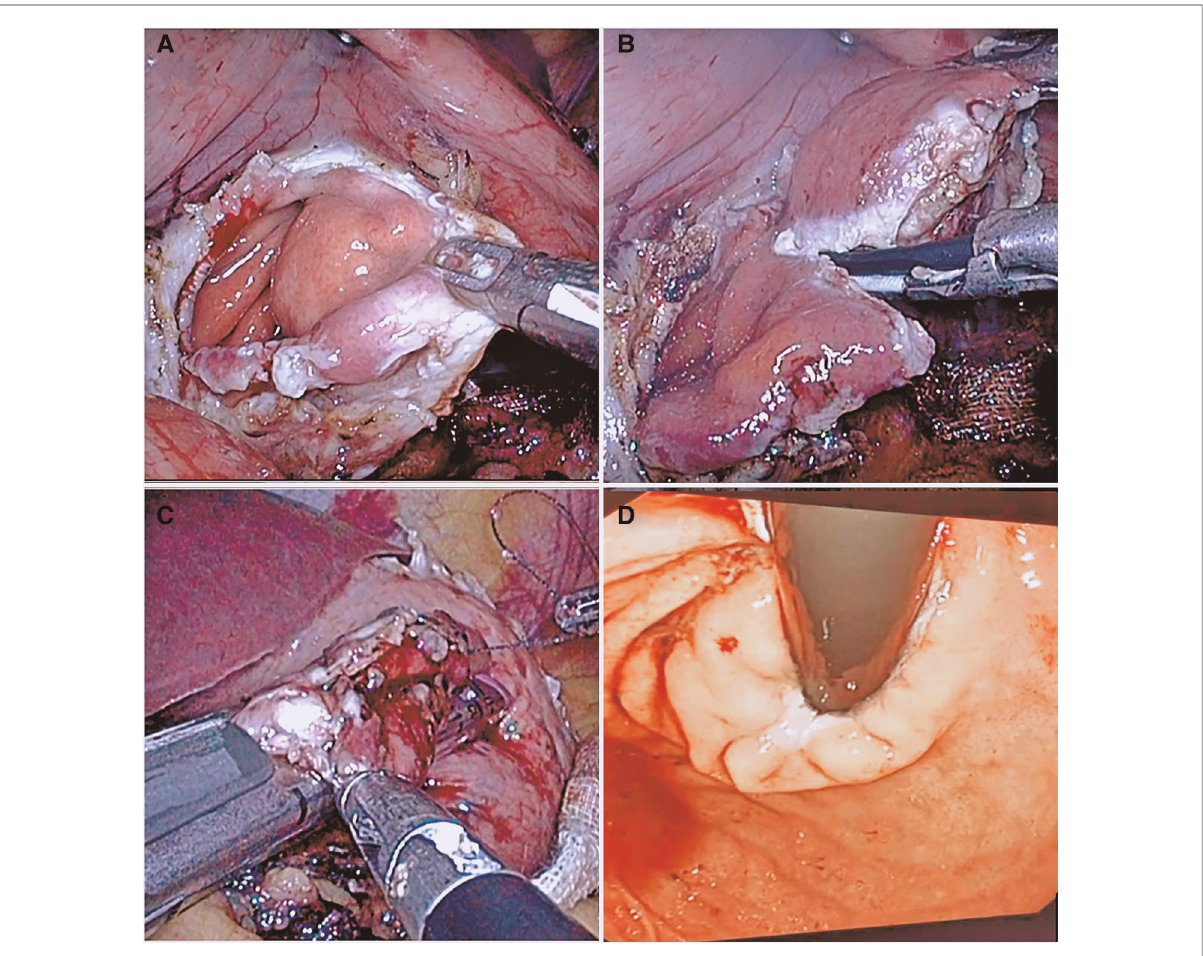
FIGURE 3 The fl ow chart of resection by opening all of the layers of the stomach wall. ( A ) The full thickness of the stomach wall was opened to expose the tumor site. ( B ) The tumor was pulled, and an ultrasonic knife was used to remove the tumor. ( C ) After the tumor was completely resected, the cardia was reconstructed using a linear cutting closer. ( D ) Intraoperative gastroscopy was performed to check the patency of the